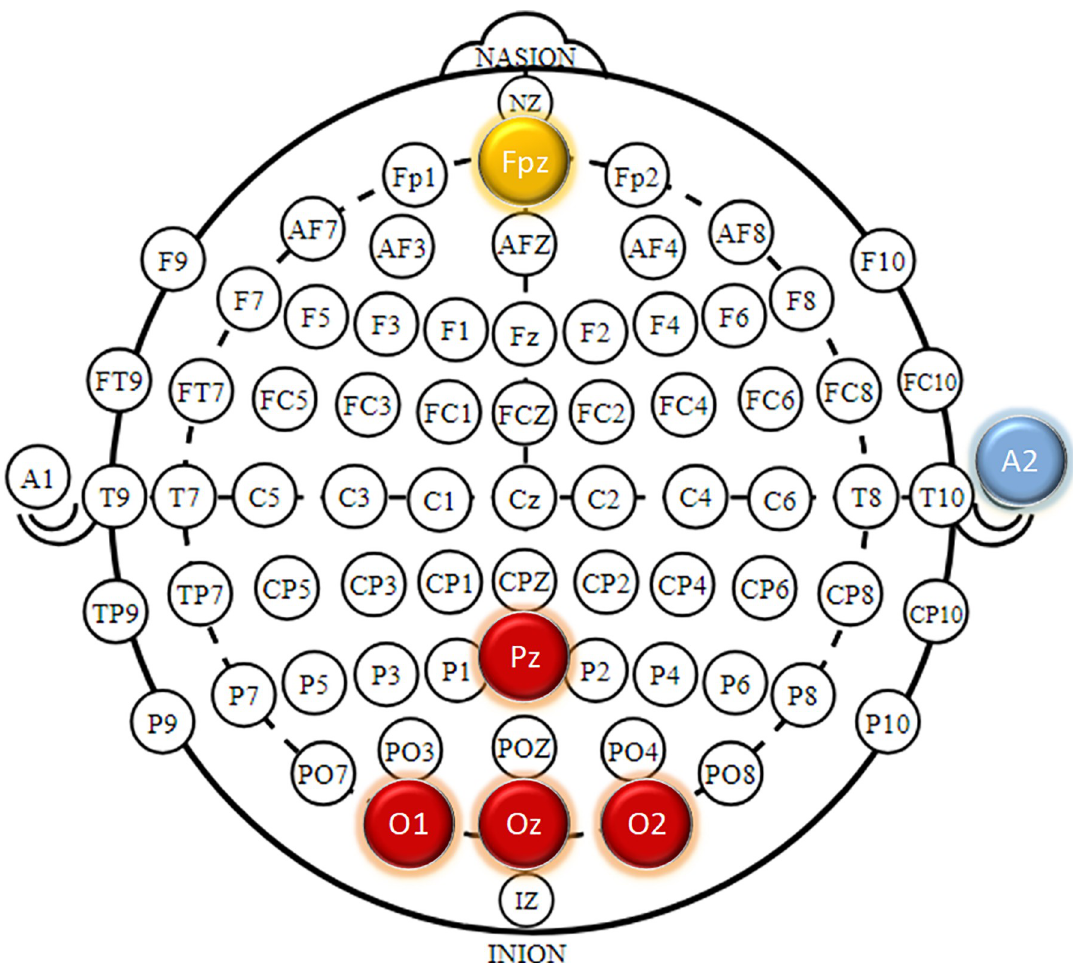
Fig 8. EEG recording electrodes placement according to 10–20 system. Four active g.laddy bird electrodes were placed in Oz, O1, O2 and Pz. A2 and Fpz were selected as the reference and ground electrodes respectively.